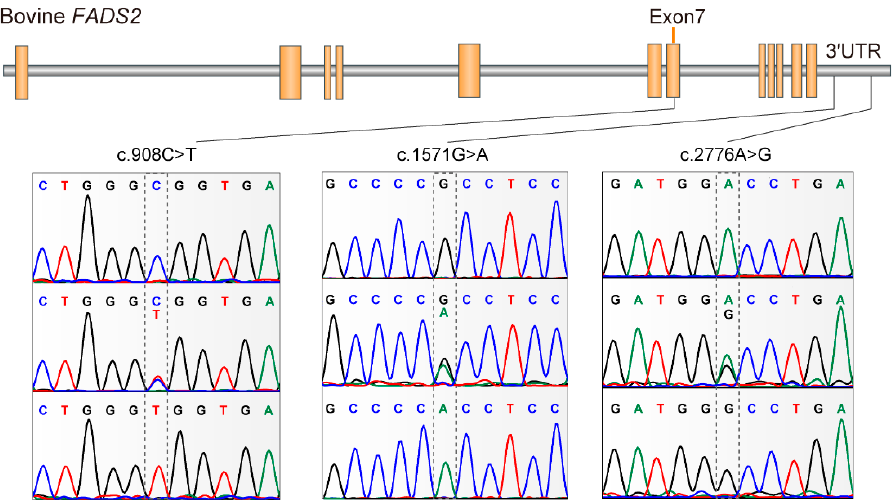
Figure 1. Schematic diagram of the fatty acid desaturase 2 gene with the localization of the three identified single nucleotide polymorphisms (SNPs).